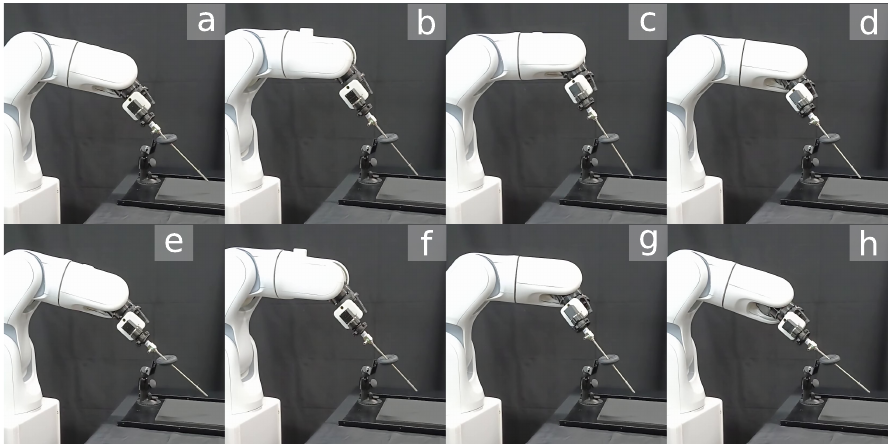
Figure 12. Snapshots of a robotic endoscope holder tracking a 4-DOF helix path subjected to an RCM constraint. The labels ( a – h ) indicate the sequence of the robot’s movement along the